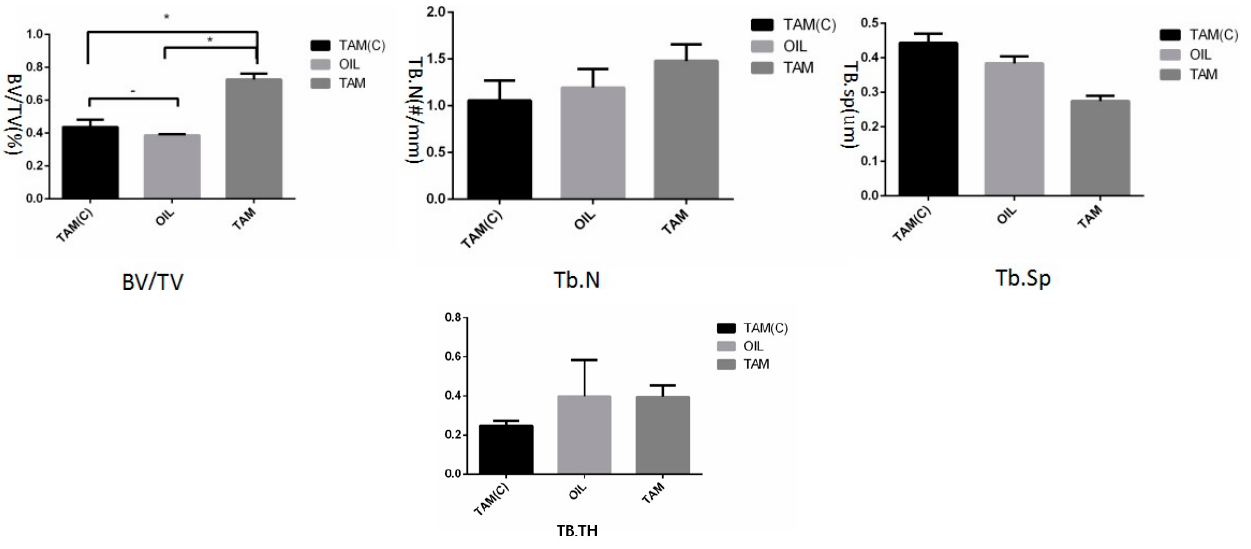
Figure 4. Analysis of skull bone mass index. The BV/TV of the TAM group is significantly higher than that of the Oil group and the TAMc group ( p < 0.05): Tb.N tends to increase, Tb.Sp tends to decrease, and Tb.TH has no statistical difference. * means p <